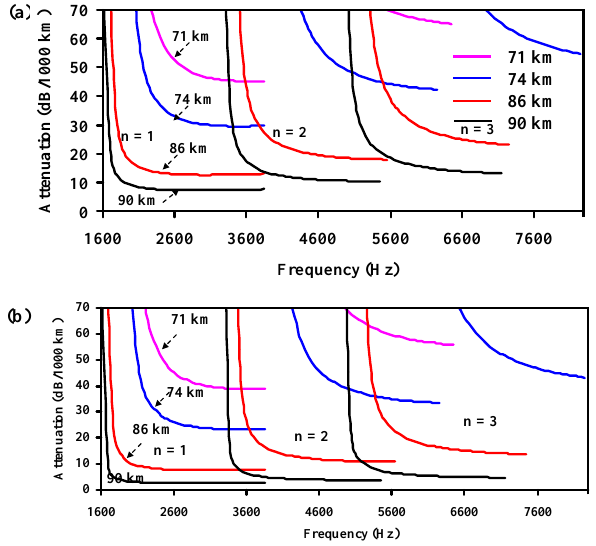
Fig. 2. Attenuation per 1000 km of tweek sferics propagating in the waveguide formed by (a) ground and the lower ionosphere, and (b) sea surface and the lower ionosphere.